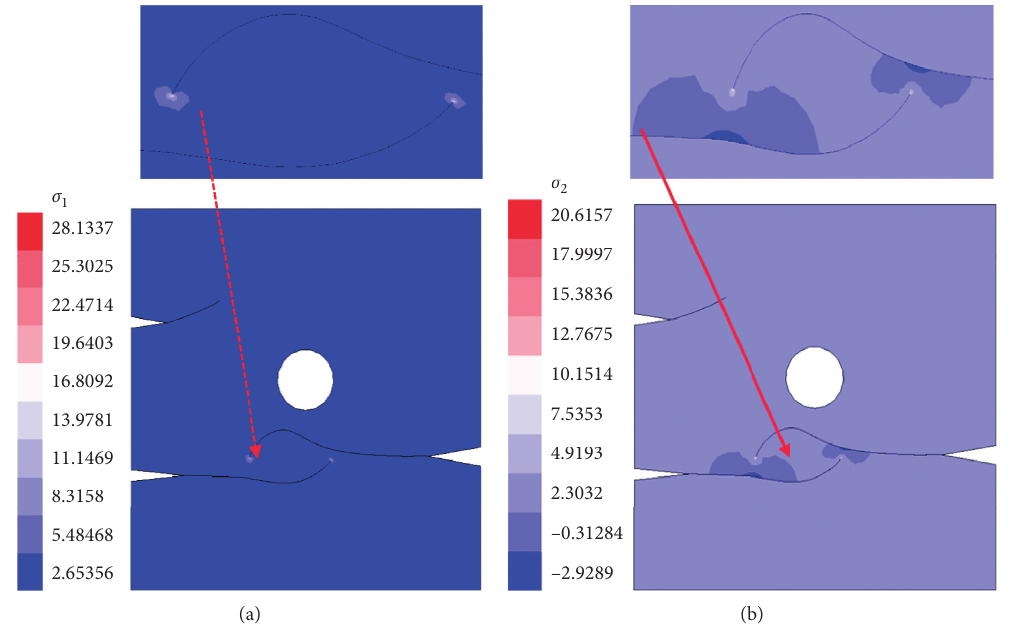
Figure 10: The maximum and minimum principal stress distribution for the last step of the crack growth.